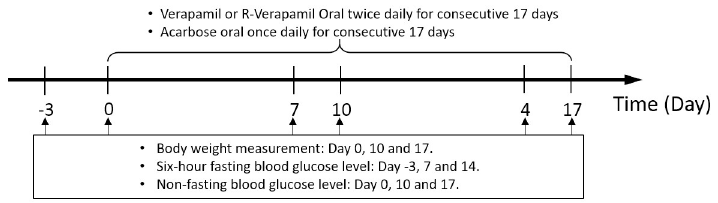
Fig 3. Scheme of db / db mice administered verapamil and R-Vera combined with acarbose.